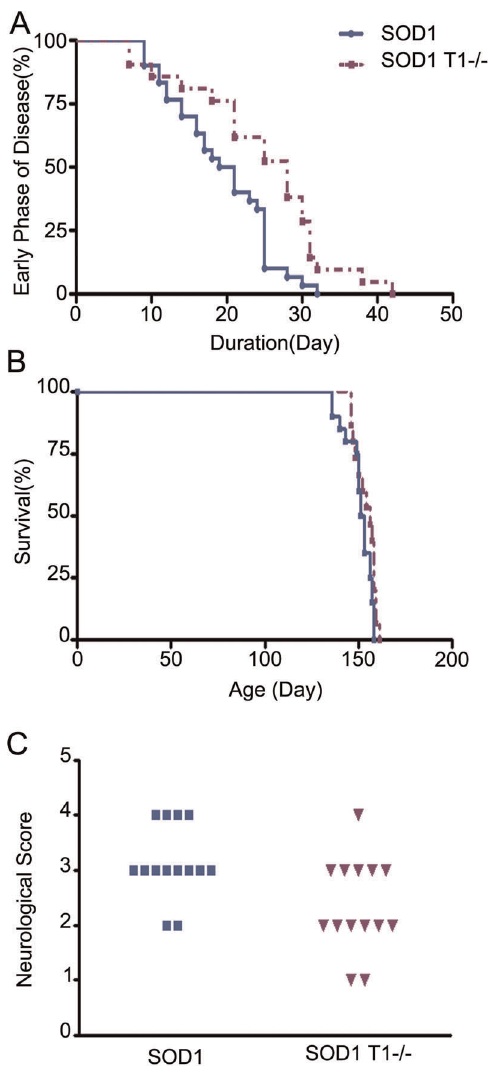
Figure 3. Disease progression and survival of SOD1 and SOD1;T1 2 / 2 mice. Histograms from Kaplan-Meier analysis showing the duration of the early phase (A) and the end stage (B) of the disease, as well as the neurological scoring (C) of SOD1 and SOD1;T1 2 / 2 mice. Deletion of TrkB.T1 delays the early phase of disease progression by 6 days (19.2 6 1.25 days, n=30 in SOD1 animals versus 25.2 6 2.09 days n=21 in SOD1;T1 2 / 2 , P , 0.05; A). Note the similar life span between groups (B) despite the improvement in the overall neurological score at 20 wk in the SOD1;T1 2 / 2 compared to the SOD1 mutant mice (C; P , 0.05).